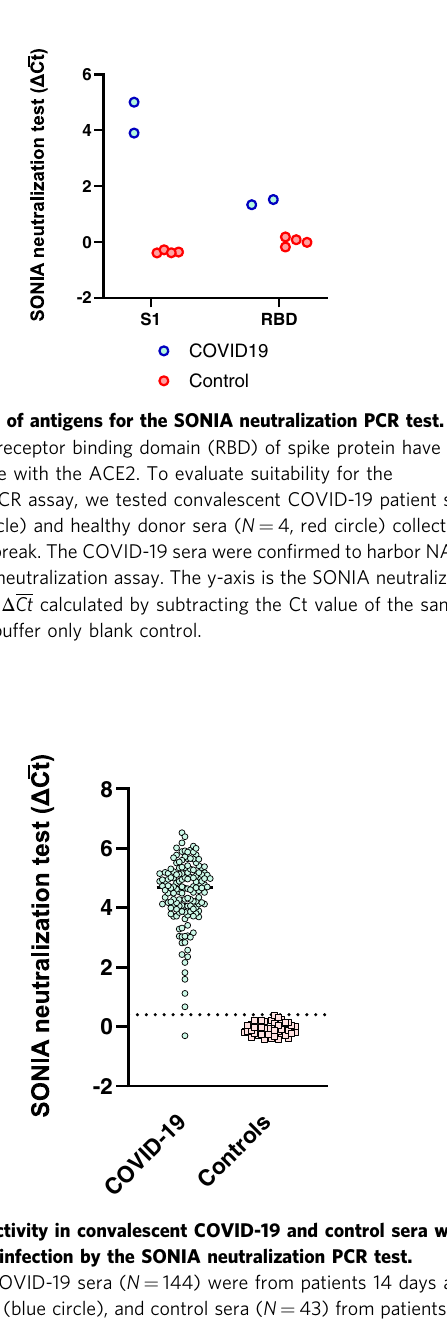
Table 1 Analysis of SONIA neutralization test with samples characterized by VNT ( N = 189). NAb titer by VNT